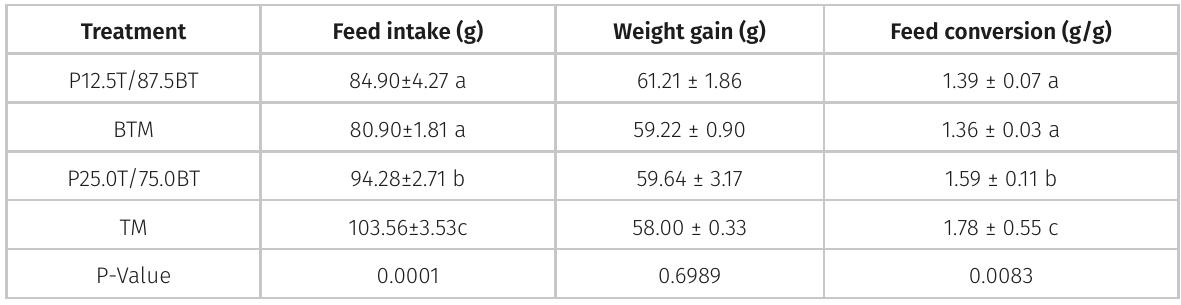
Table VI. Feed intake (g), weight gain (g) and feed conversion in polyculure breeding of fingerlings Nile tilapias (T) and bullfrog tadpoles (BT), tilapia monoculture (TM) and a bullfrog tadpole monoculture (BTM) in the experiment 2.